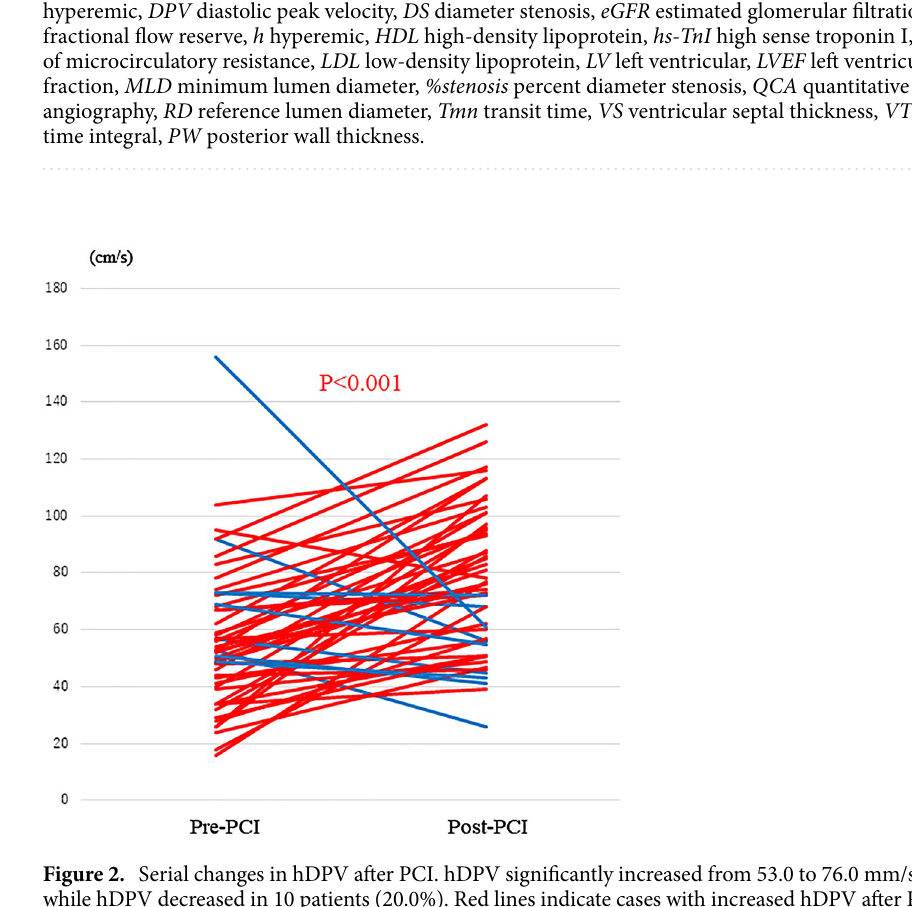
Table 1. Baseline patient characteristics. Data are presented as n (%), mean SD, or median (interquartile range). A peak inflow velocity during late diastole, ACE-I angiotensin-converting enzyme inhibitor, ARB angiotensin receptor blocker, averaged e ′ , average of septal e ′ and lateral e ′ , b basal, CFR coronary flow reserve, CFVR coronary flow velocity reserve, CRP C-reactive protein, DMV diastolic mean velocity, E peak inflow velocity during early diastole, e ′ mitral annular velocity during early diastole on the septal or lateral side, h